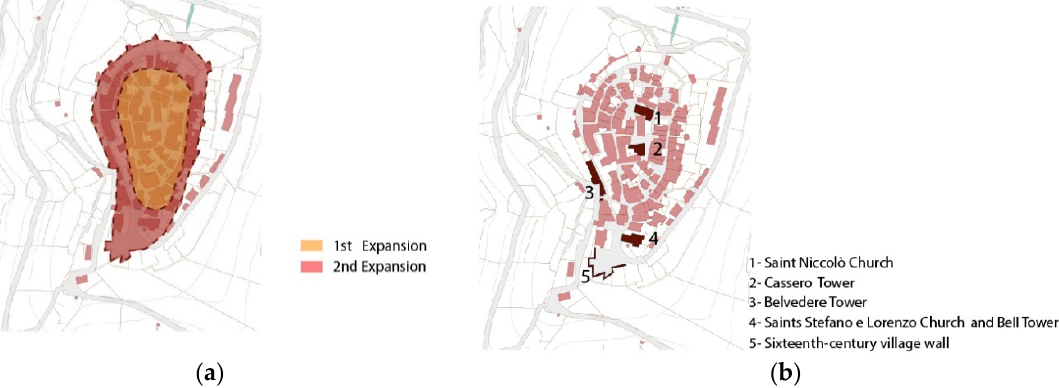
Figure 3. ( a ) Construction phases; ( b ) Identification of the main historical buildings.